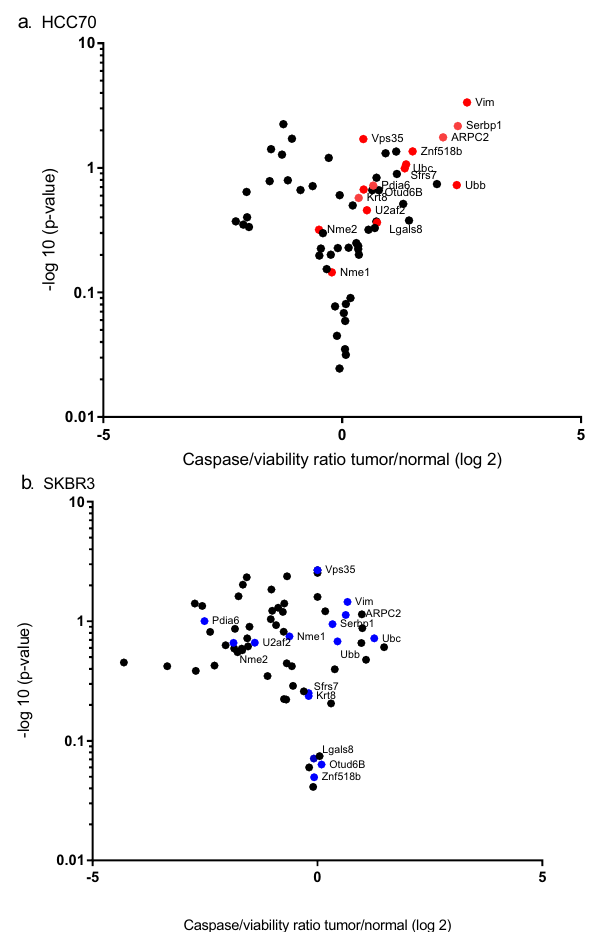
Fig. 1 Volcano plots demonstrate siRNA knockdown of the candidate antigens has increased tumor cell line cell death as compared to the normal cell line. Four pooled siRNA were used to knock down expression of each of the sixty-three targets. Evaluation of the apoptosis to cell survival ratio (caspase/viability ratio) in a triple negative (red, HCC70), and b HER2 positive (blue, SKBR3) human breast cancer cell lines were compared to a non-malignant breast cell line (MCF10F). Y axis is – log10 and X axis is log2. Targets were selected with higher caspase/cell viability ratio in at least one of the breast cancer cell lines as compared to non-malignant breast cell line ( p ≤